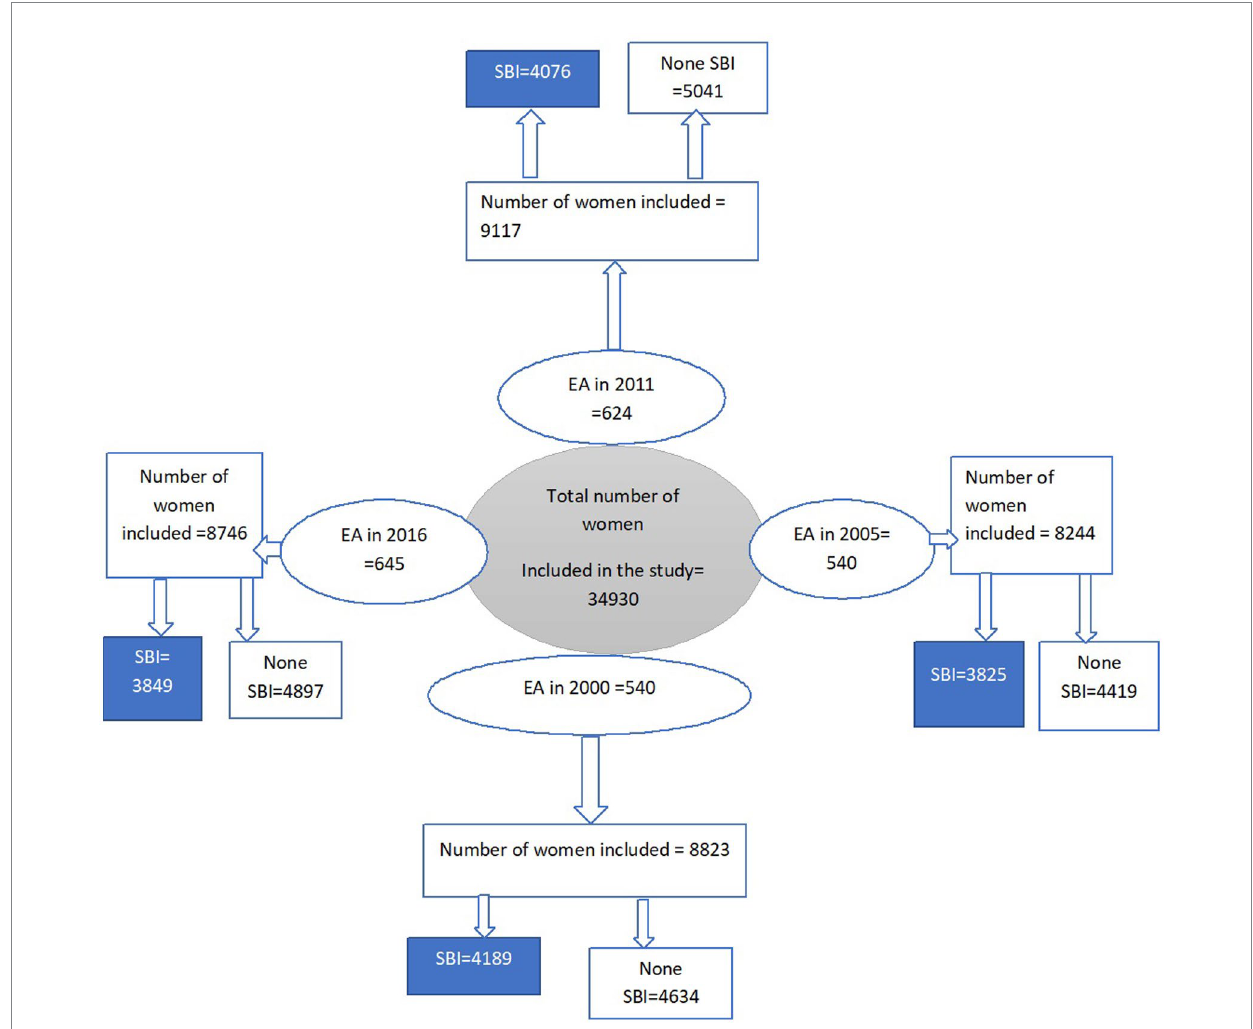
FIGURE 1 The flowchart for the data extraction procedure from EDHS 2000 to 2016,